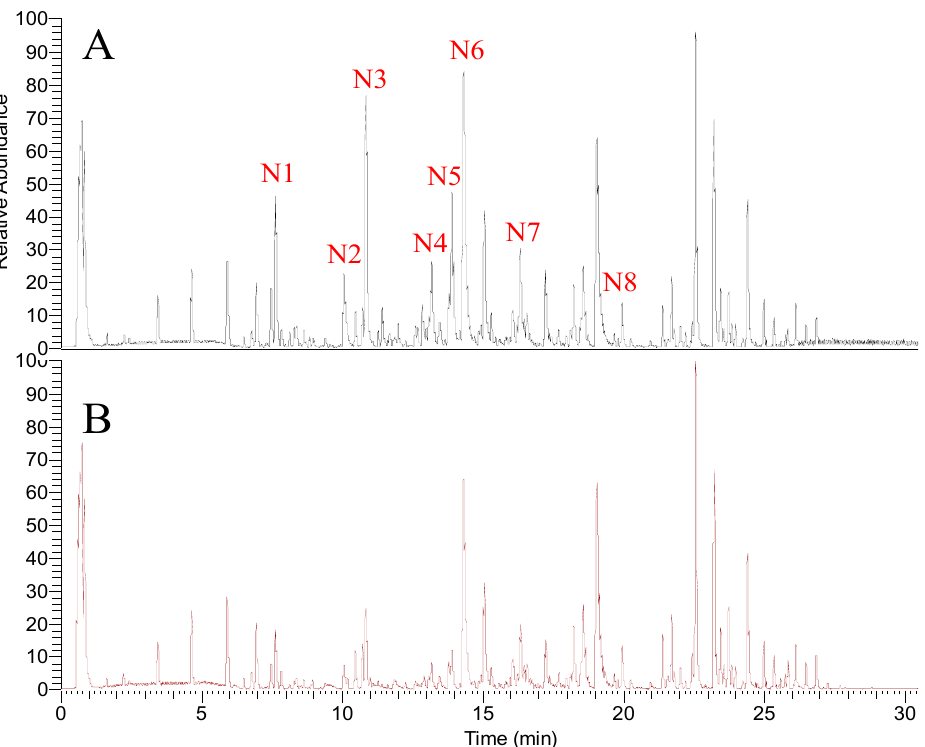
Figure 3. The base peak chromatograms (BPC) of untreated ( A ) and tyrosinase-treated samples ( B ) of A. keiskei in negative ion mode.